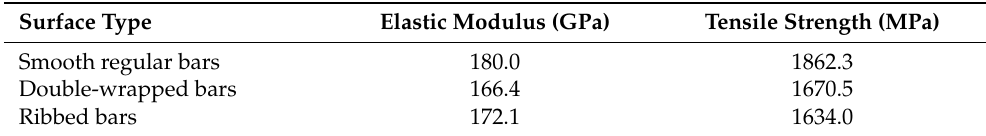
Figure 2. CFRP bars with different surface shapes: ( a ) smooth regular bars; ( b ) double-wrapped bars; ( c ) ribbed bars. Table 2. Mechanical properties of CFRP bars.